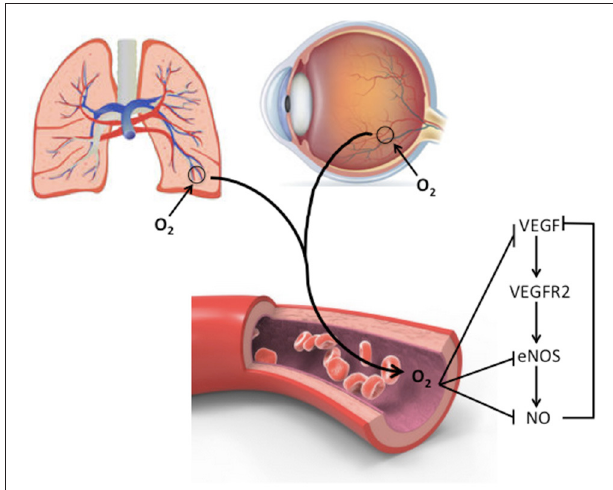
FIGURE 2 | Interaction of O 2 with VEGF and eNOS signaling. Oxygen can disrupt VEGF and NO signaling pathways via down regulation of eNOS. Abbreviations are as documented in